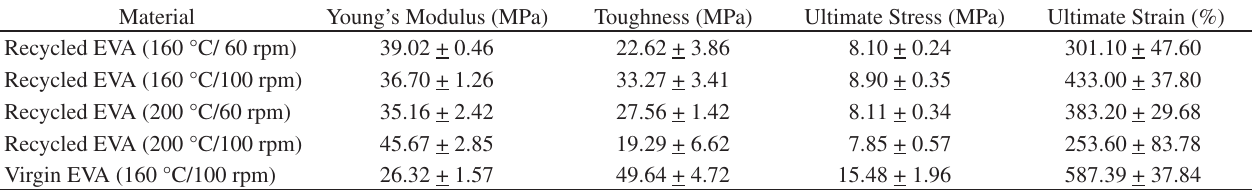
Table 1. Tensile mechanical properties of recycled and virgin EVA as a function of the processing temperature and velocity. Material